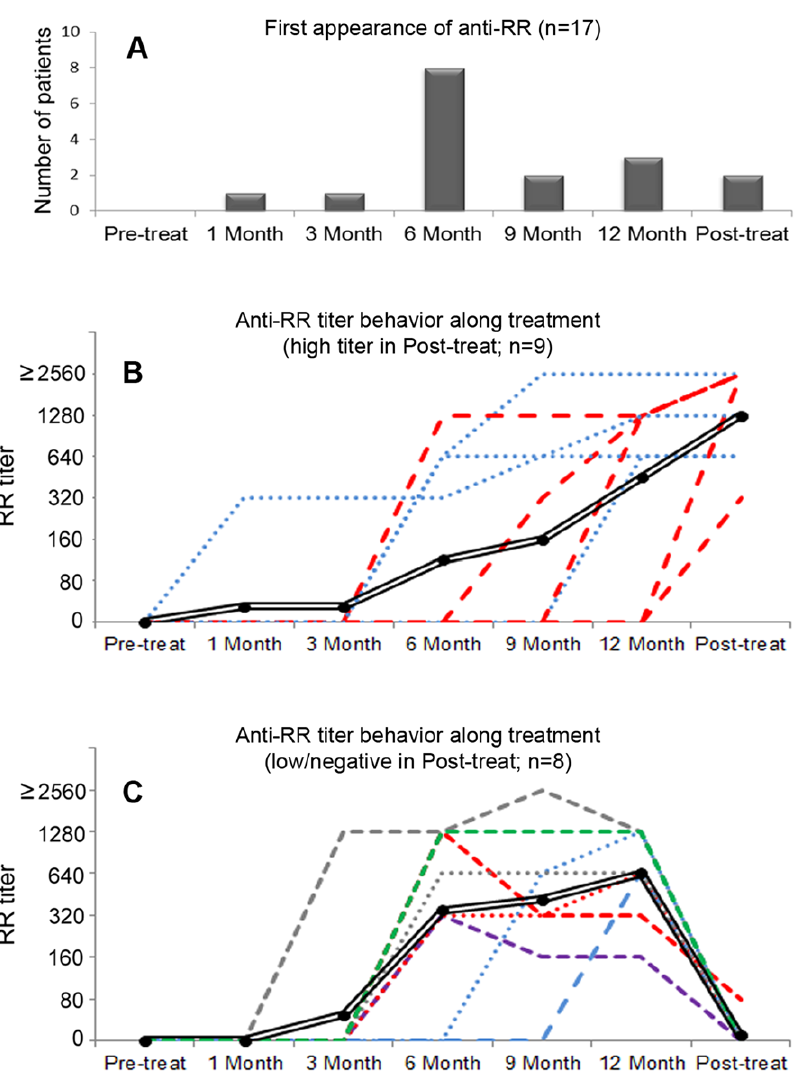
Figure 5. Anti-RR first appearance and titer behavior during and after treatment discontinuation. (A) Time for first appearance of anti-RR reactivity. For those 17 patients included in this analysis, 8 (47%) presented anti-RR reactivity at the sixth month of treatment and two produced their first anti-RR sample after treatment discontinuation (in red dashed lines in panel B). (B) Nine patients kept or increased the titer of anti-RR after treatment discontinuation. Titer showed a trend for increasing along anti-HCV treatment and after treatment discontinuation. Double black line=overall trend; red dashed line=anti-RR titer increased after treatment discontinuation (n=5); blue dots line=anti-RR titer was stable after treatment discontinuation (n=4). (C) In eight patients, anti-RR reactivity became negative (color dashed and dots lines, n=7) or dropped down to 1/ 80 (red dashed line, n=1) after treatment discontinuation. Double black line=overall trend. 0=negative. Dilution was from 1/80 into 1/2560 for this